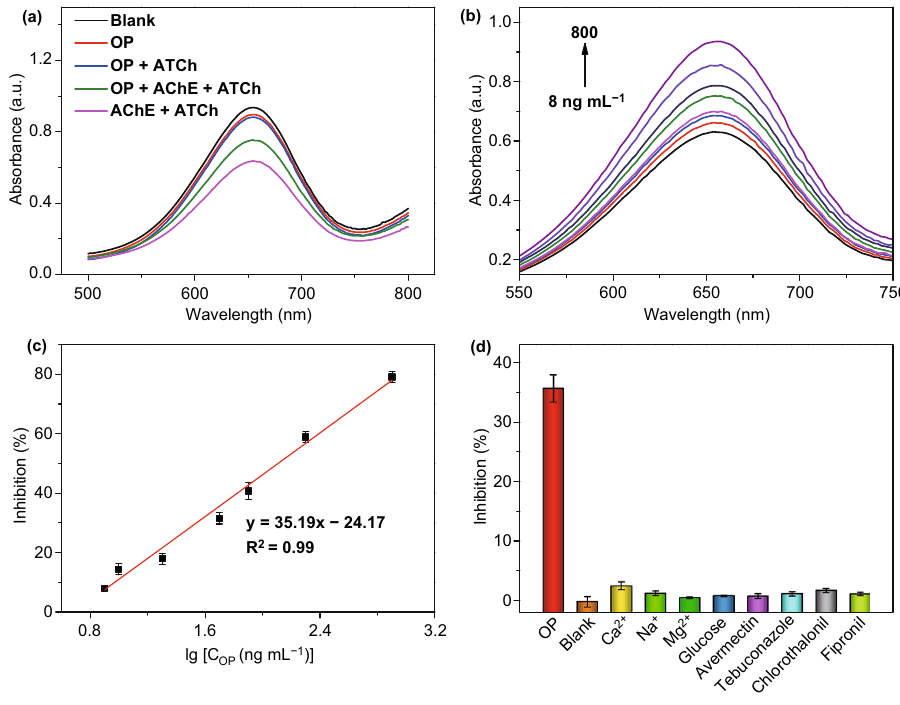
Fig. 5 a Absorption spectra of OP, OP + ATCh, OP + AChE, and OP + ATCh + AChE in the NO 2 -MIL-101-based biosensor. b Absorption spec- tra of AChE-integrated biosensor in the presence of different amounts of OP. c A linear relationship between the concentration of OP and inhibi- tion of AChE activity. d Selectivity test of NO 2 -MIL-101-based biosensor in the presence of interfering